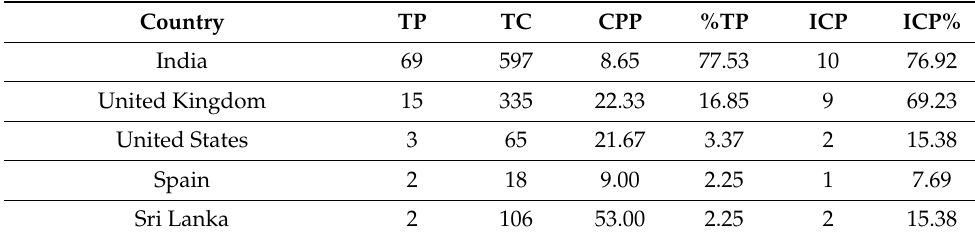
Table 4. The top five countries on dhat syndrome research (n =